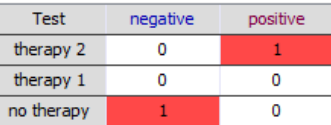
Figure 8. Optimal policy of Therapy : the best choice (with probability 1) is “therapy 2” when the test is positive and “no therapy” when it is negative.